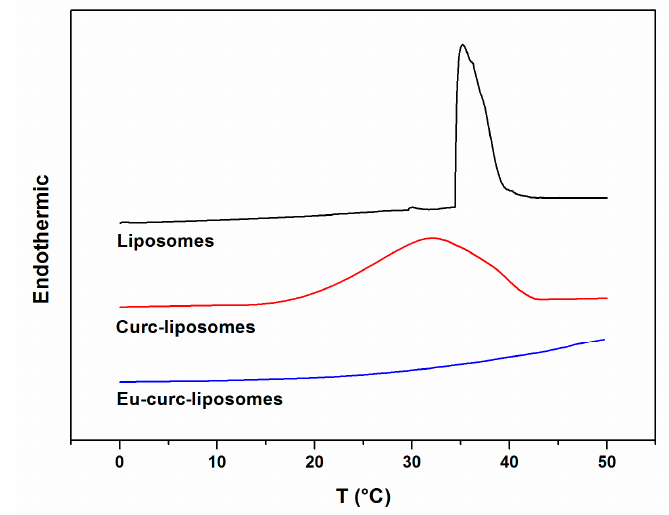
Figure 3. Differential scanning calorimetry (DSC) thermograms of liposomes, Curc-liposomes, and